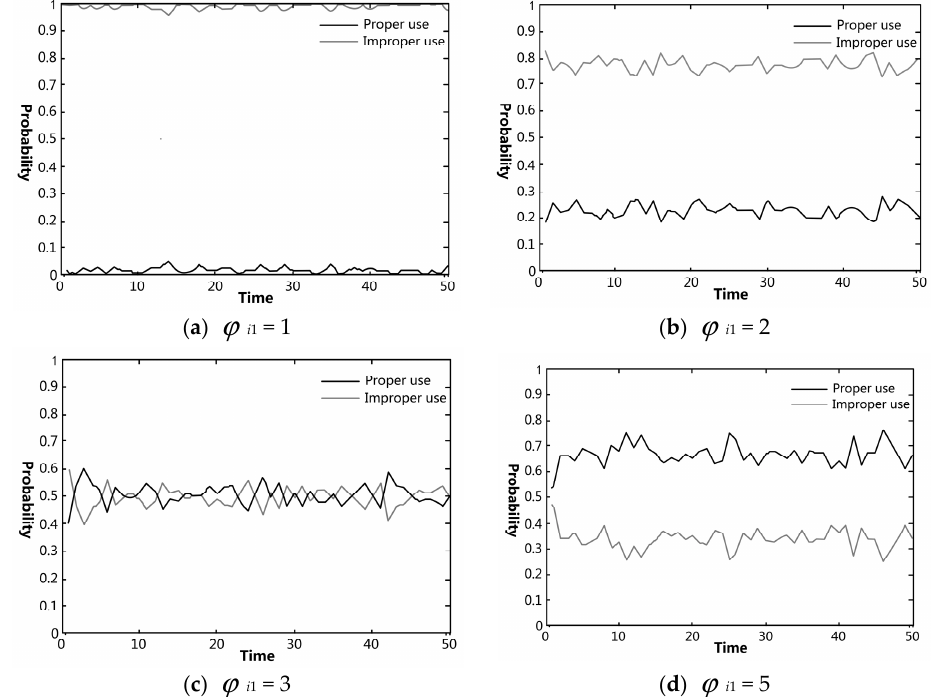
Figure 2. Simulation results of the changes of farmers’ behavioral choices regarding VA use under the variation of their knowledge about VA use specification: ( a ) the value of ϕ i 1 (the farmers’ knowledge of VA use specification) was set to 1; ( b ) the value of ϕ i 1 was set to 2; ( c ) the value of ϕ i 1 was set to 3; ( d ) the value of ϕ i 1 was set to 5.